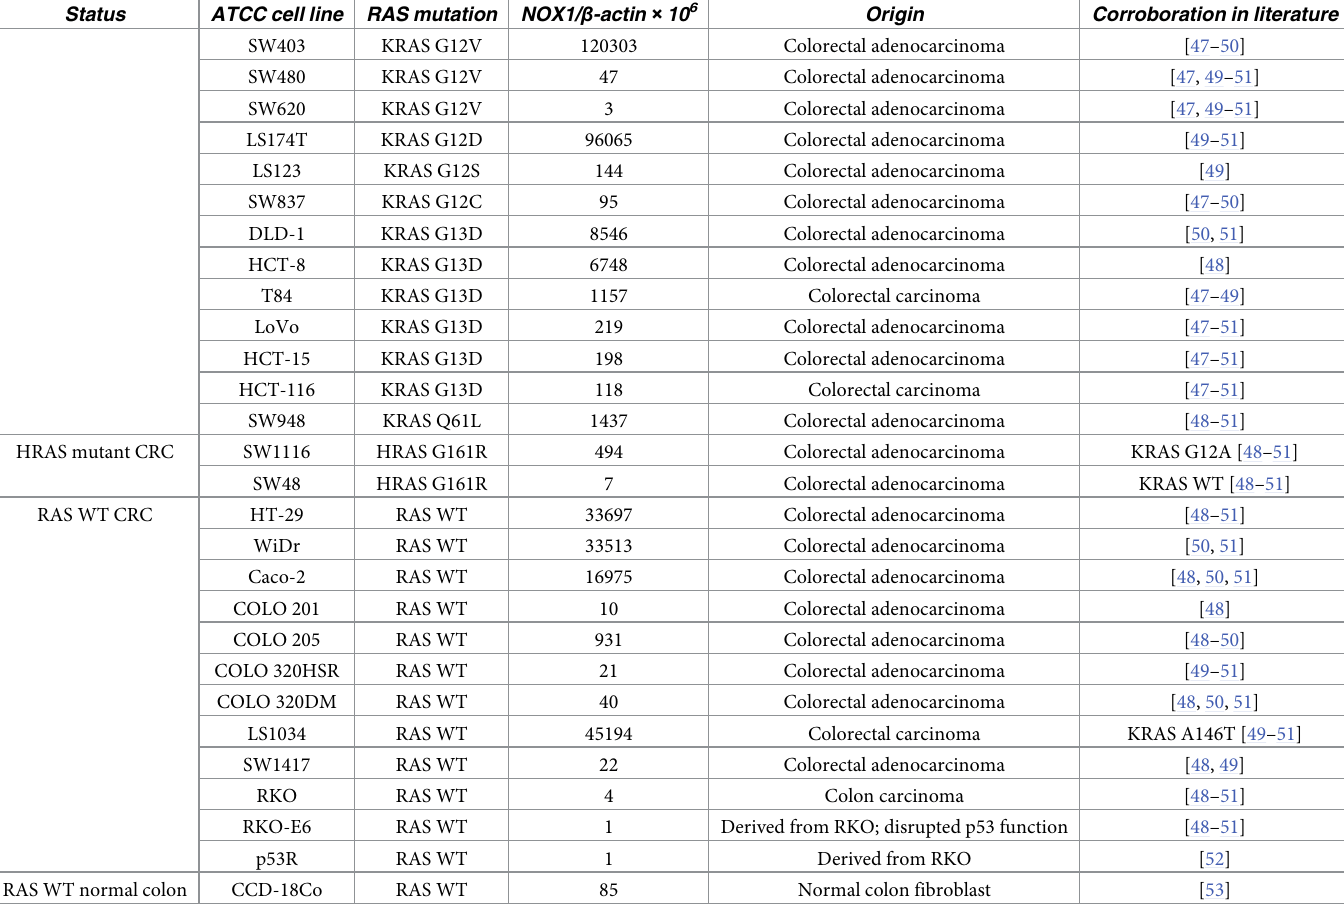
Mutations were identified by Sanger sequencing, and NOX1 mRNA level was measured by PCR and normalized to β -actin. CRC, colorectal